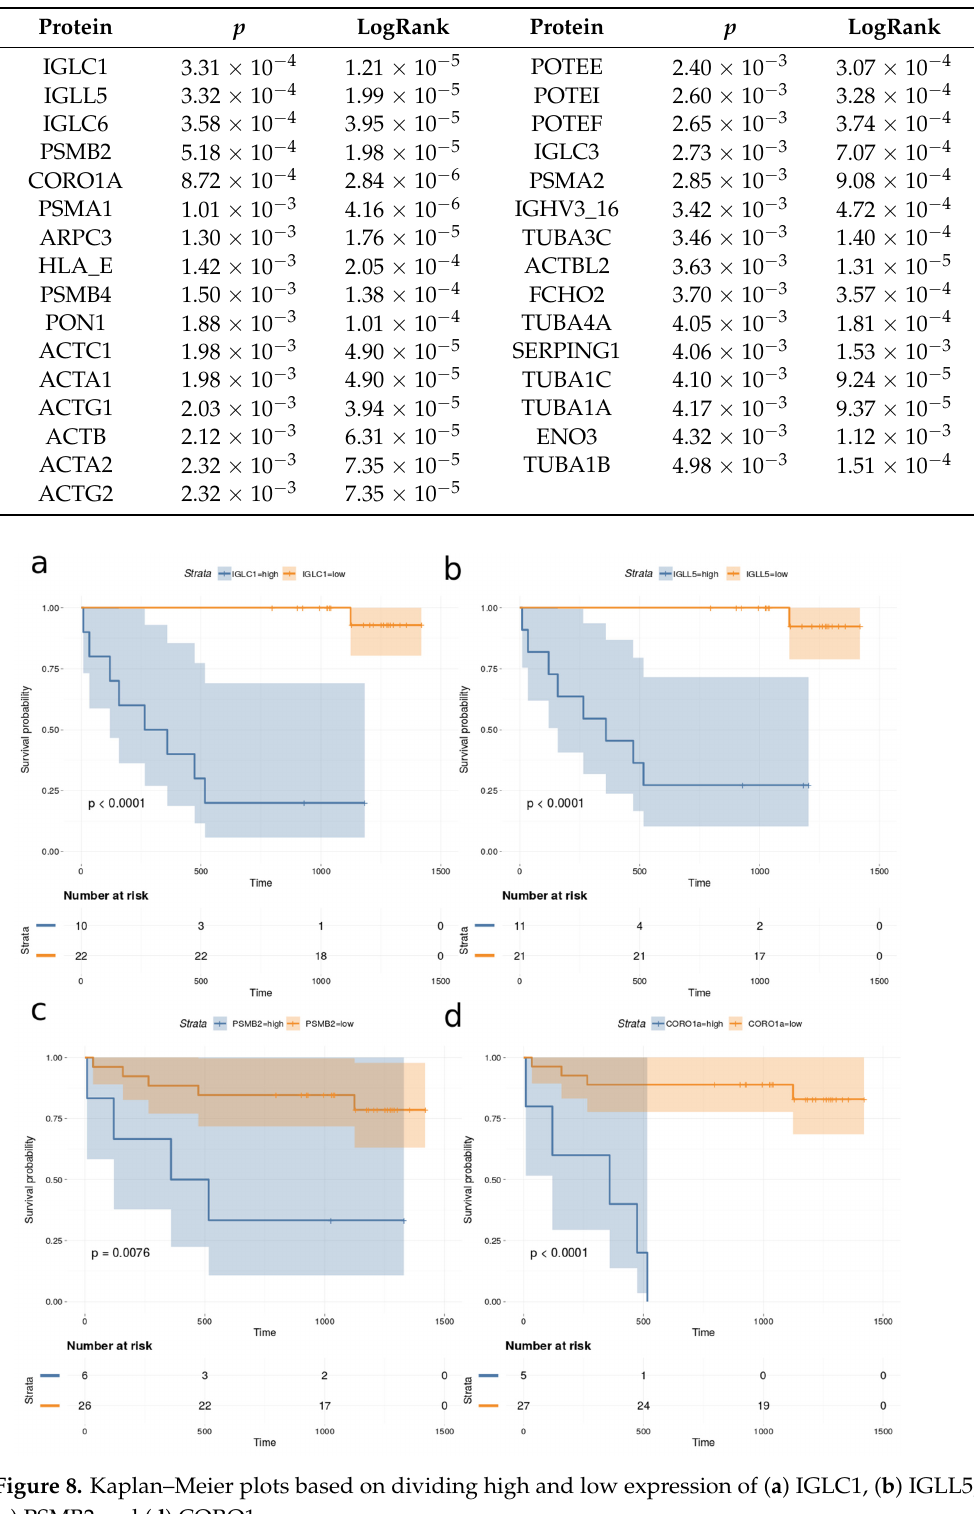
Table 2. Cox–Mantel log-rank tests and p -value estimates from Cox proportional hazards regres- sion models.